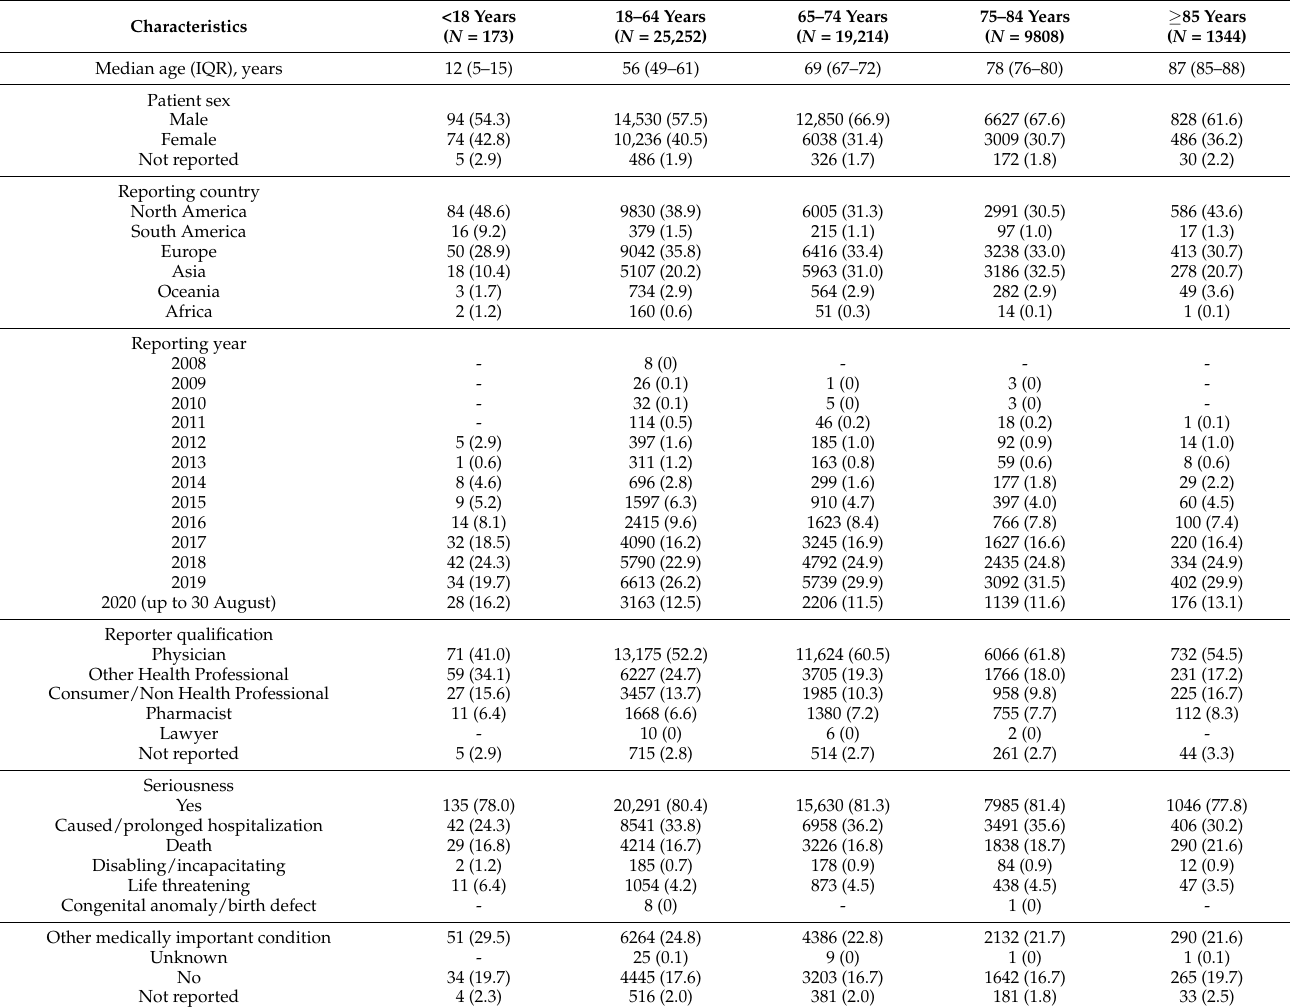
Table 1. Baseline characteristics of immune checkpoint inhibitor-related safety reports by age